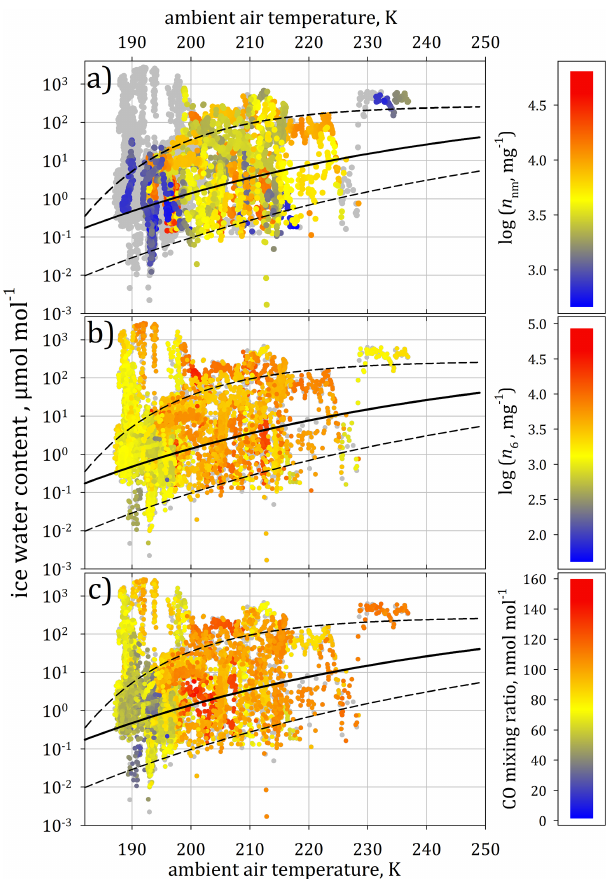
Figure 6. NPF in the IWC– T parameter space (Krämer et al., 2016): measured ice water content (IWC) coincidently detected with CO- PAS data as a function of ambient air temperature throughout Stra- toClim 2017 (1Hz resolved). Data points are colour-coded referring to (a) the detected mixing ratios of nucleation-mode particles, n nm ; (b) the total mixing ratio n 6 ; and (c) the carbon monoxide (CO) mixing ratio. Note: in panel (a) , the data points are grey if data of n 6 − 15 are available, while colours are apportioned only to those n nm (i.e. n 6 − 15 ) complying with the NPF criterion. Generally, the black lines represent the median (solid) and the upper- and lower- most bounds (dashed) of the core IWC band, respectively, as ob- tained from earlier measurements at other locations (Krämer et al.,